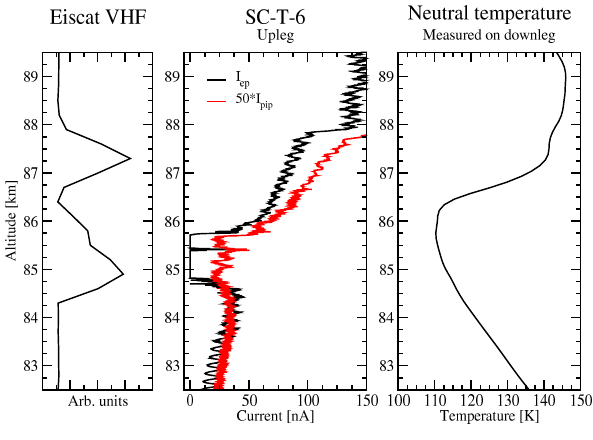
Fig. 9. Electron biteout measured during the SCALE campaign in 1993(Blix, 1999). The left panel shows PMSE as measured by the EISCAT VHF (224MHz) radar. The middle panel shows the cur- rents to the electron probe, I EP , and the positive ion probe, I PIP ( I PIP has been scaled with a factor of 50 for presentation purposes). The right panel shows the neutral temperature, as measured by the CONE instrument on